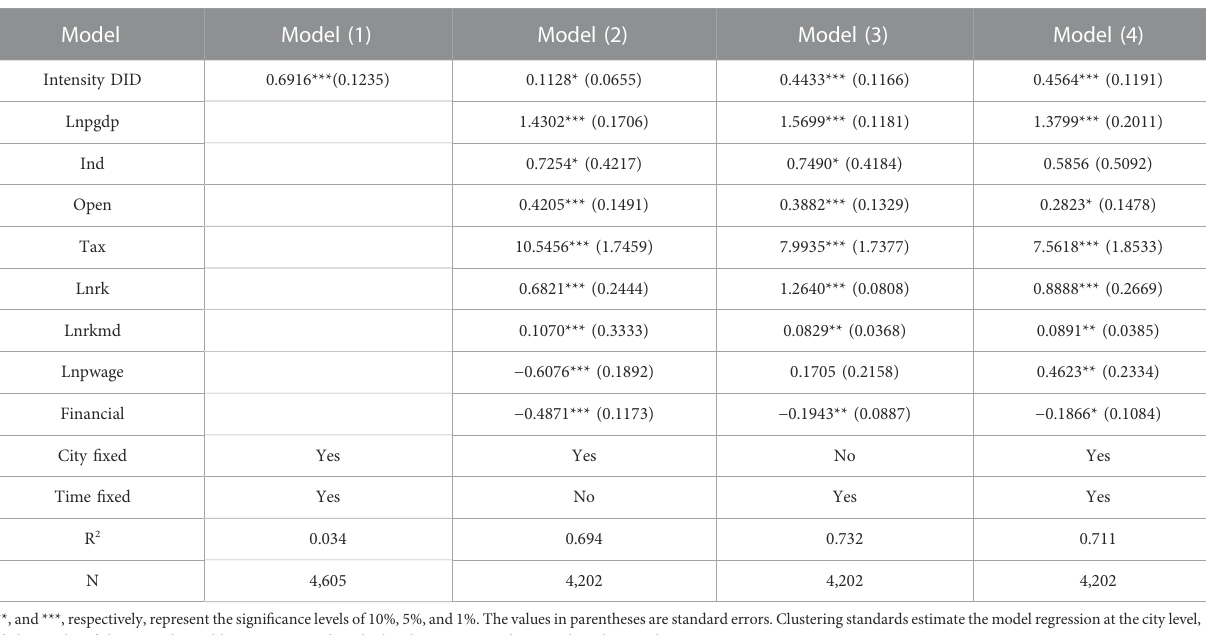
TABLE 3 Baseline regression.